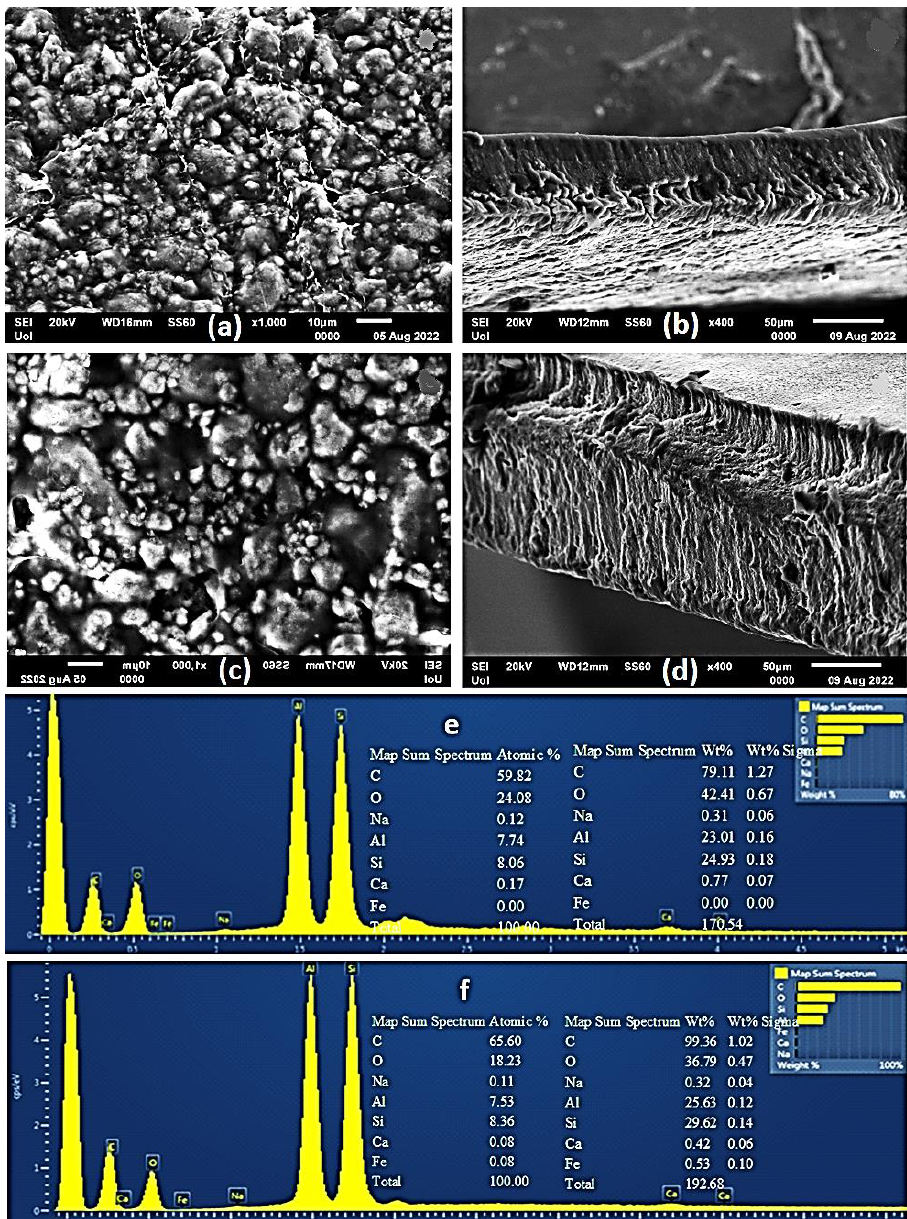
Figure 7. ( a , c ) SEM images of the surface and ( b , d ) cross-section for the nanocomposite films of ALG/G/15HNT ( a , b ) and ALG/G/15TO@HNT ( c , d ) respectively. ( e , f ) Energy dispersive spectrometer (EDS) spectrum and relative elemental analysis of the surface (inset) from the SEM images ( a , c ).